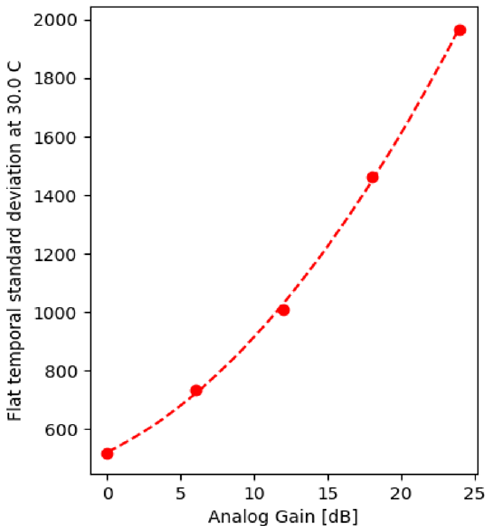
Figure 15. Shot noise as a function of analog